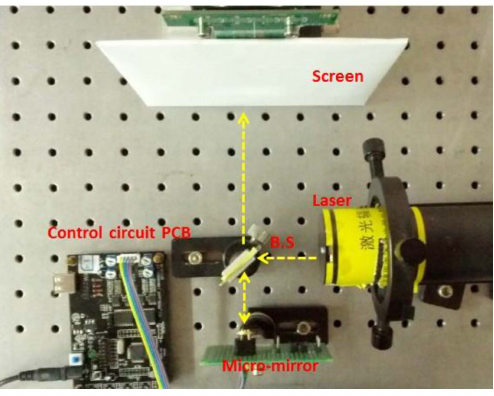
Figure 9. The laser scanning system that was constructed based on the MEMS mirror. The scanning can be driven by standard driven signals or by the model-based open-loop control system.